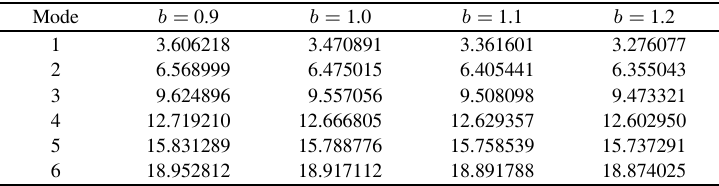
Table 9 Non-dimensional natural frequencies of free-free rods with A ( x ) = A 0 sin 3 ( ax + b